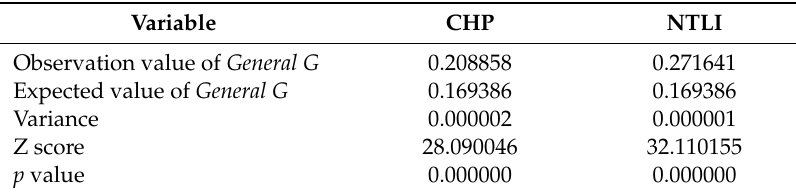
Table 2. General G